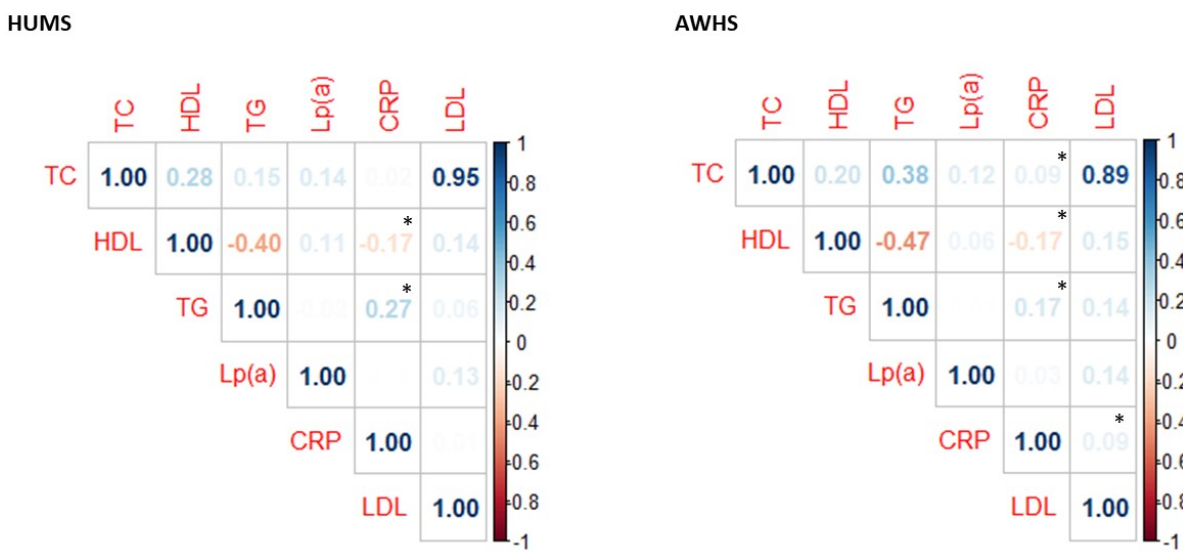
Figure 1. Correlation between CRP levels and lipid profile in AWHS and HUMS cohorts. * p < 0.05 calculated using the Spearman method. TC: total cholesterol, HDL: high-density lipoprotein cholesterol, TG: triglyceride, Lp(a): lipoprotein (a), CRP: C-reactive protein, LDL: low-density lipoprotein cholesterol.